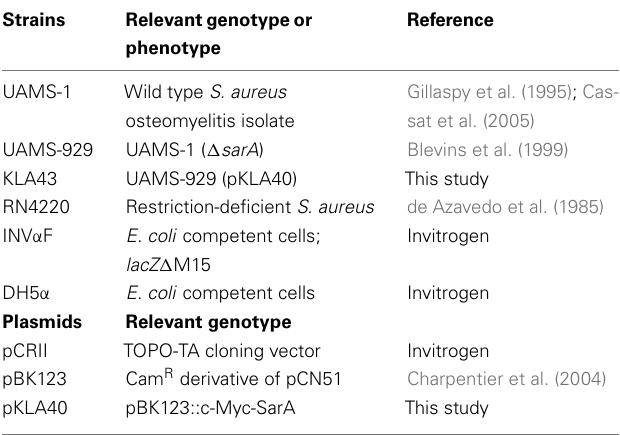
Table 1 | Bacterial strains and plasmids used in this